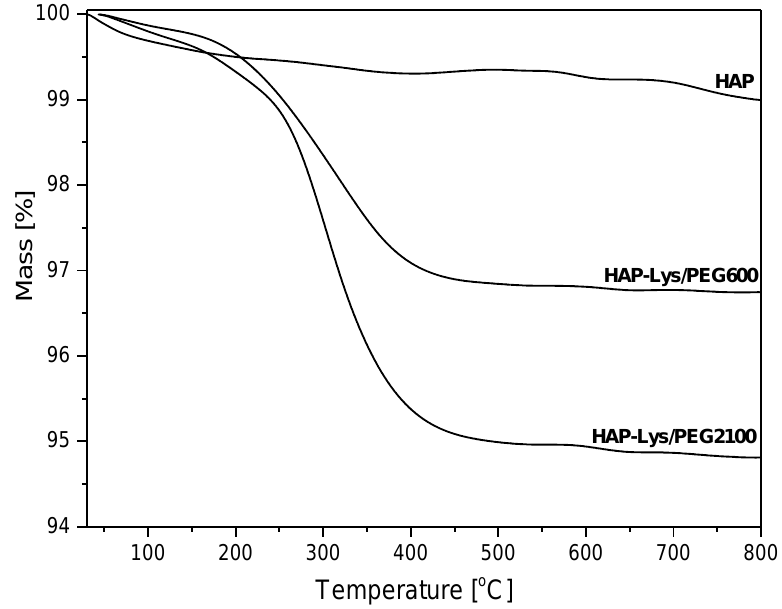
Figure 2. TGA curves of hydroxyapatite, hydroxyapatite modified with L -lysine and PEG600 (HAP-Lys/PEG600), and hydroxyapatite modified with L -lysine and PEG2100 (HAP-Lys/PEG2100).